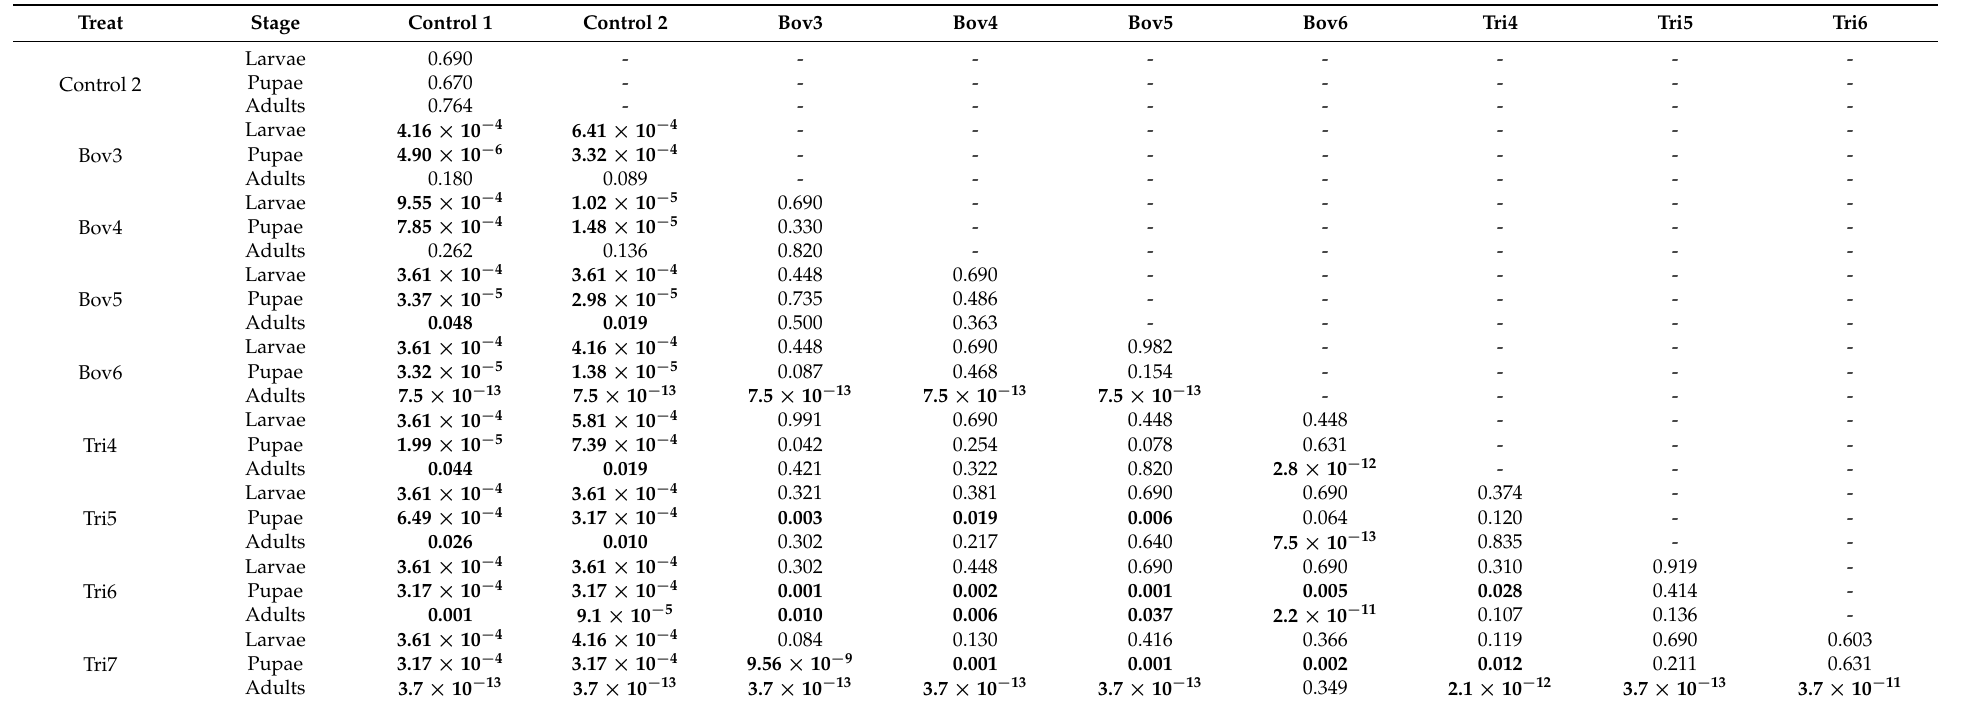
Table 2. p value of the survival analysis for Atta sexdens rubropilosa Forel 1908 (Hymenoptera: Formicidae) larvae, pupae and adults (workers).